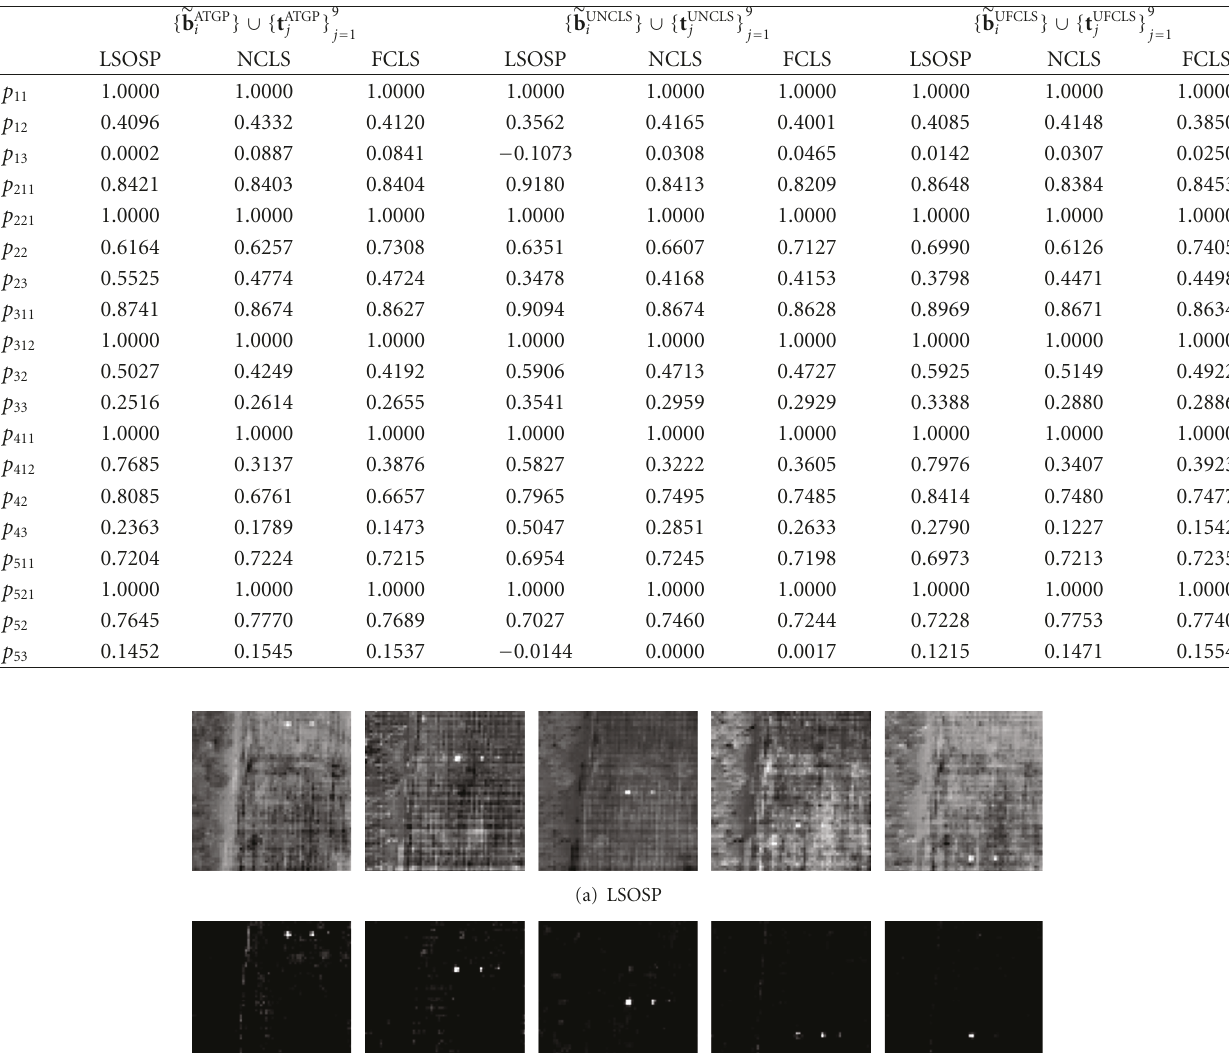
Table 3: Abundance fractions of 19 panel pixels estimated by LSOSP, NCLS, and FCLS using BKG and target pixels found in Figures 23–25 by ATGP-USTFA, UNCLS-USTFA, and UFCLS-USTFA.